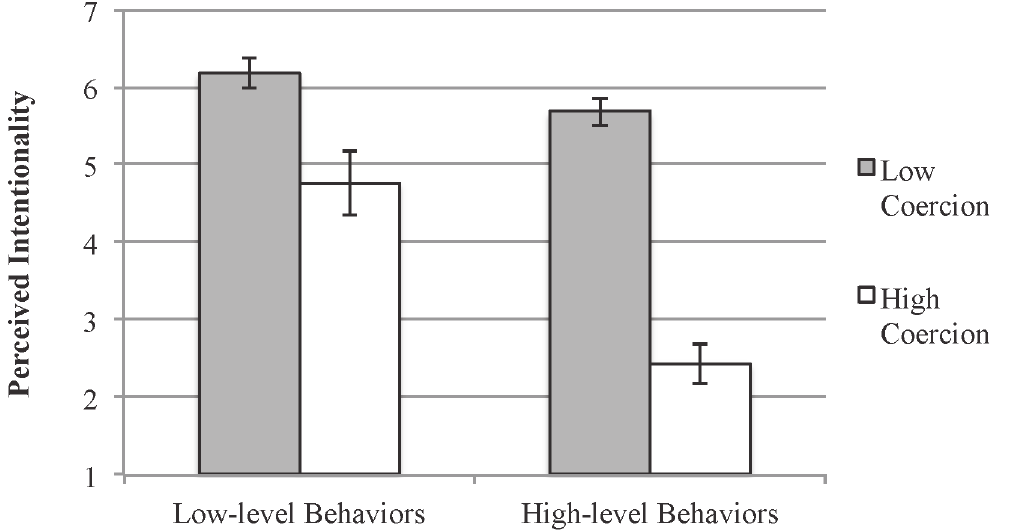
Fig 1. Mean judgments of intentionality for low-level and high-level behavior descriptions by coercion condition. Error bars = ± 1 SE.